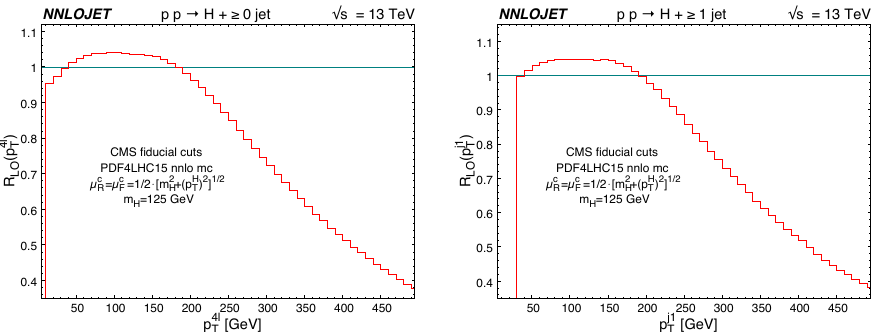
Figure 1. The scaling factor R LO ( p 4 l quark mass